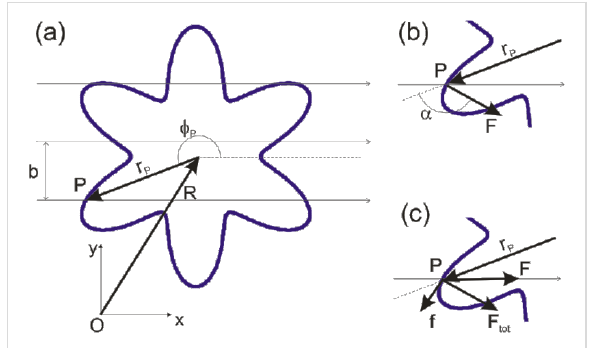
Figure 1: (a) A sharp nanotip follows a raster scan pattern with consecutive scan lines separated by a distance b . The tip collides with a nanoparticle (here represented by a star-shaped island) at the loca- tion P . (b) In tapping mode the tip oscillates in the direction z perpen- dicular to the plane of the fi gure and applies an impulsive force F perpendicular to the island pro fi le. (c) In contact mode the force F is directed along the x axis and the total force acting on the particle will be oriented as in tapping mode only if the static friction f can balance the component of F along the island pro fi